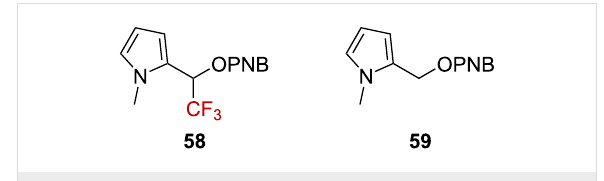
Figure 9: Structure of pyrrole derivatives 58 and 59